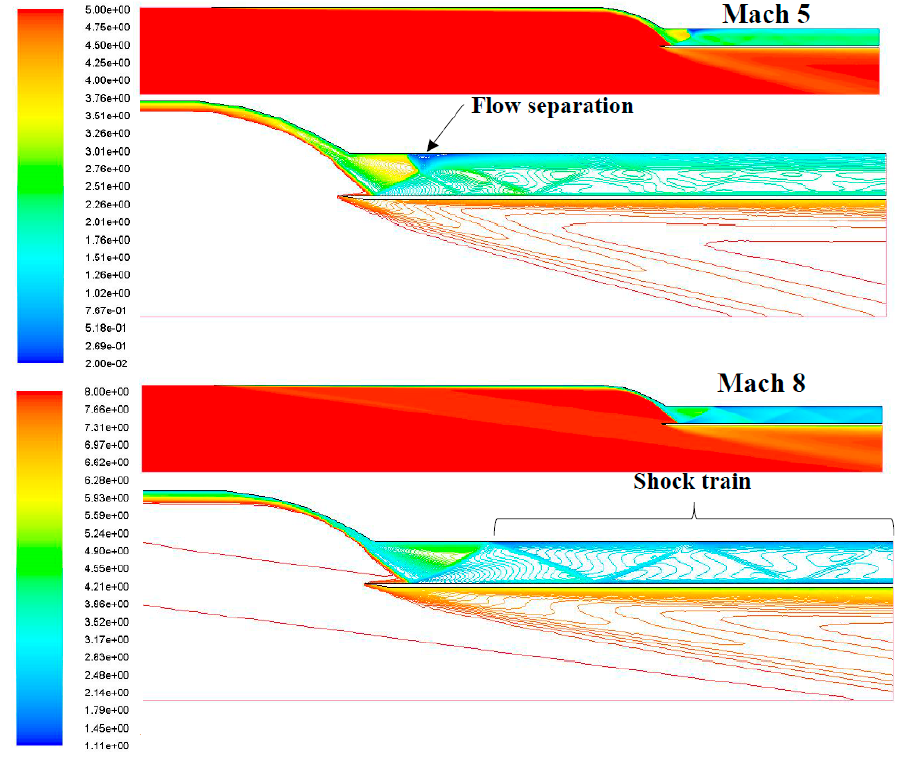
Figure 16. Mach contour of the three ramp inlet at Mach 5 and 8.